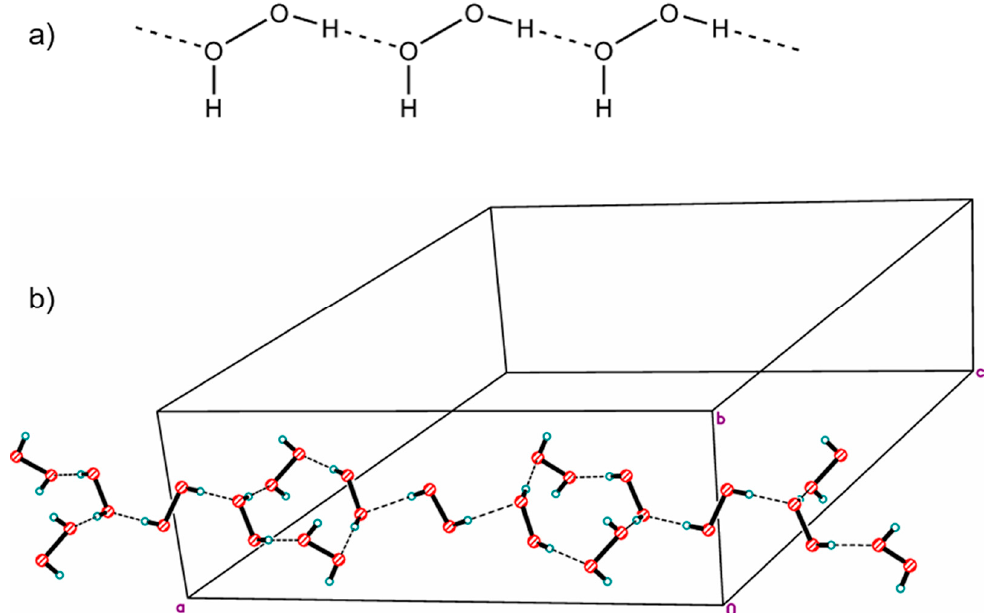
Figure 3. Infinite one-dimensional chains of hydrogen peroxide molecules: ( a ) the simplest topology C1 (YAFGEU) and ( b ) a nontrivial topology, which is a combination of alternating linear and cyclic fragments (SEMXIU). H-bonds are denoted by dotted lines.